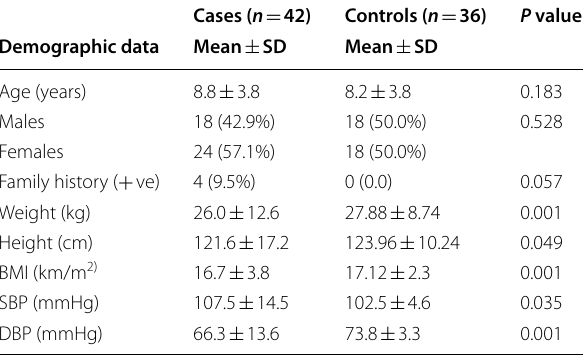
Table 1 Clinico-demographic data of studied groups